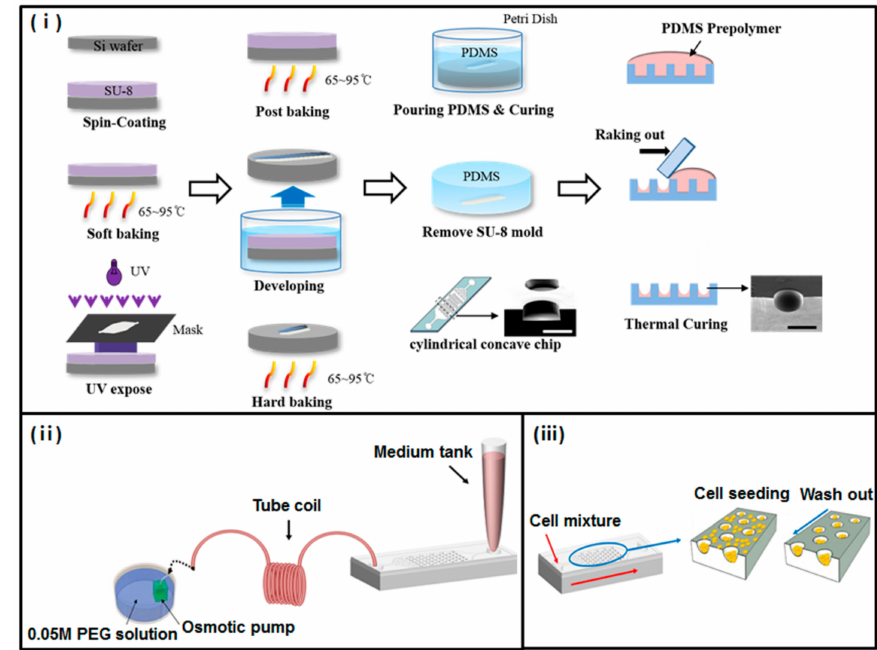
Figure 1. Fabrication of a concave microwell array polydimethylsiloxane (PDMS) plate. ( i ) Schematic diagram of concave microwell array made using the conventional soft-lithography procedure and meniscus of the PDMS pre-polymer. ( ii ) Experimental setup. Micropipette tips were used as inlet reservoirs. The osmotic pump was dipped into the polyethylene glycol (PEG) solution to generate the flow rate of the microsystem; the coiled tube was used as an outlet reservoir. ( iii ) Schematic process of cell seeding and docking within concave microwell structures. After gently aspirating cells that were not docked, the remaining cells docked within concave